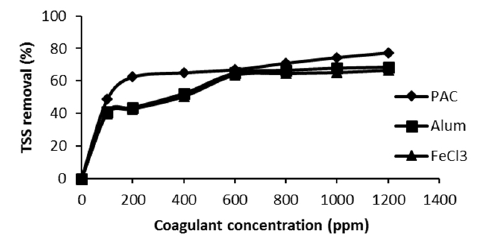
Figure 4: The consequences of the Jar test in the interval of TSS removal for different concentrations of PAC, Alum, FeCl3